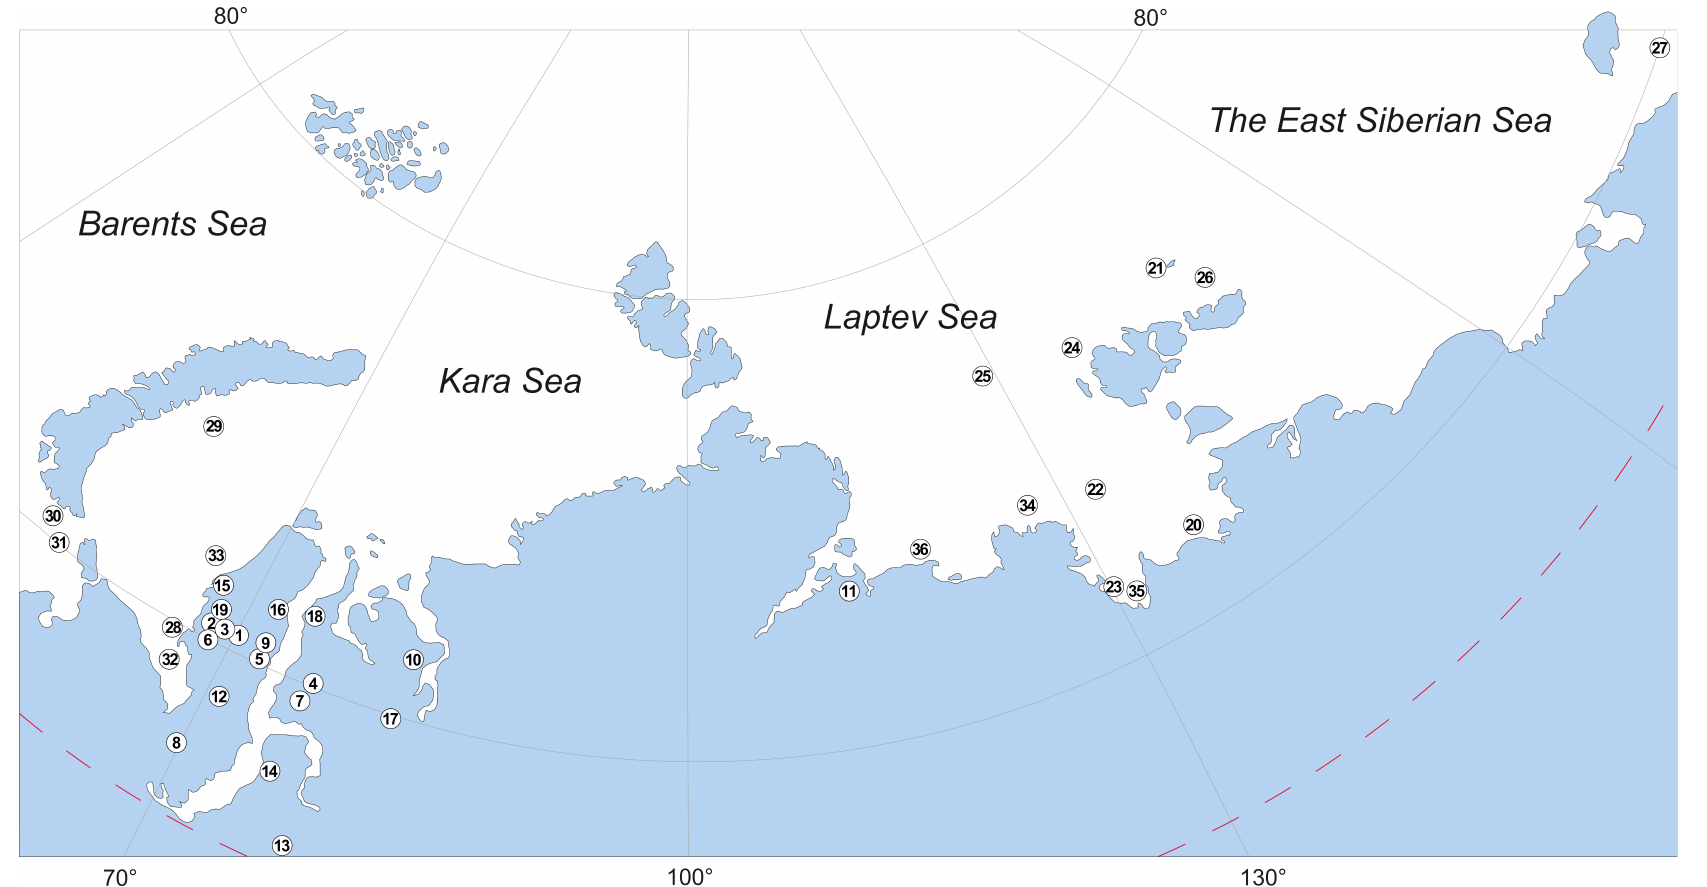
Figure 1. Map of gas emission sites in the Russian